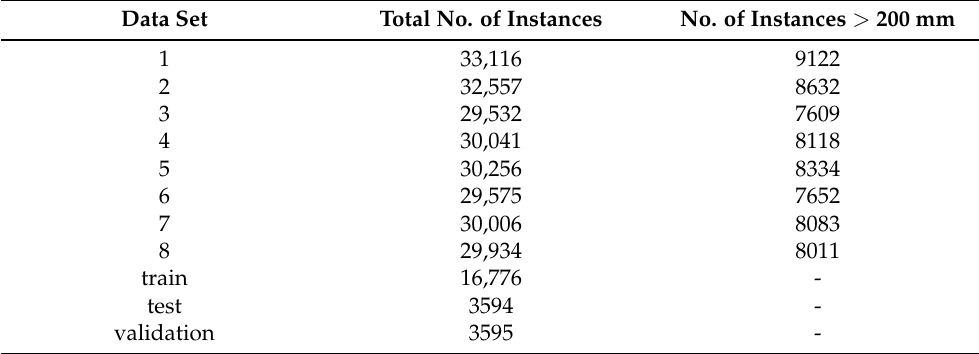
Table 2. Properties of used data sets.